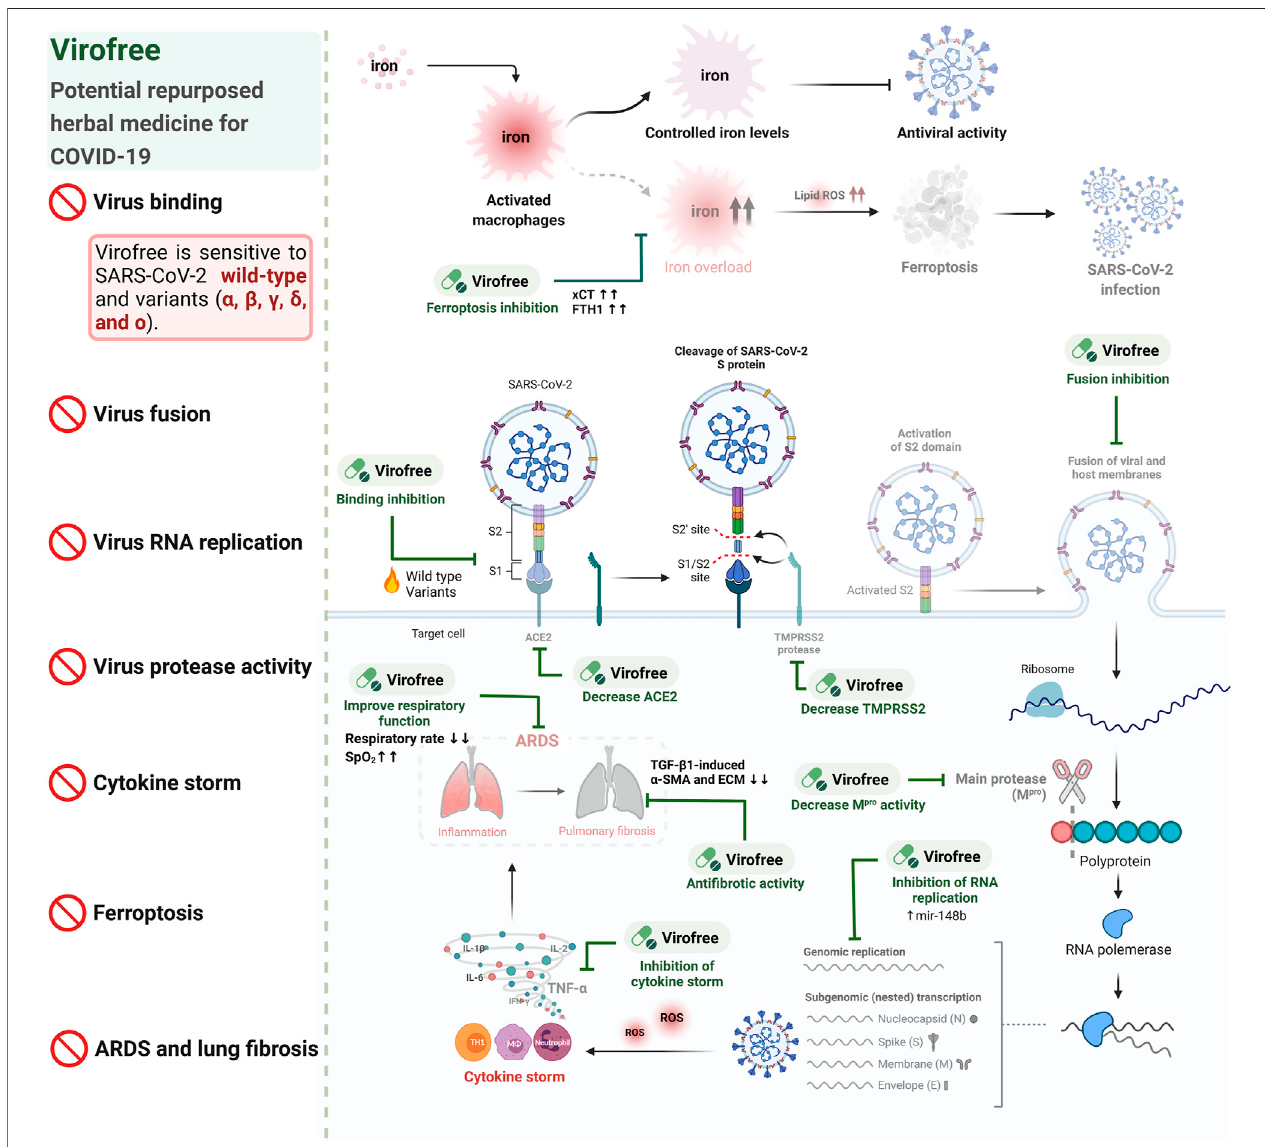
FIGURE 7 | Virofree is a candidate therapeutic treatment for